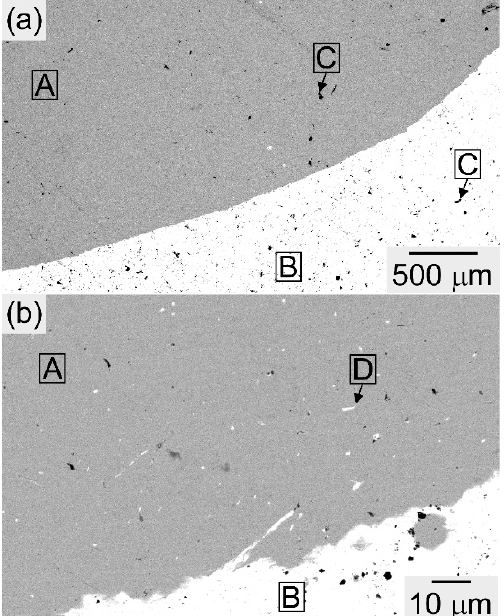
Figure 4. SEM-BSE image of the arc-melted ingots of the equiatomic AgCoCrFeMnNi HEA with a macroscopic phase-separated structure. ( b ) is the magnified image of ( a ) focusing on the macroscopically phase-separated interface.